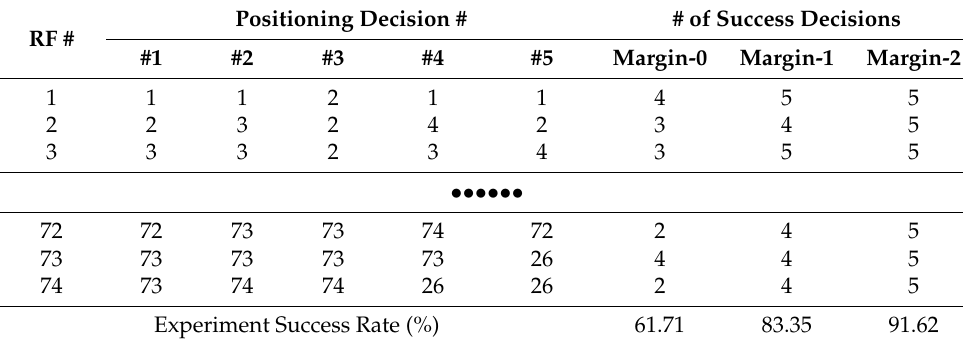
Table 6. The example of real time testing experimental results.